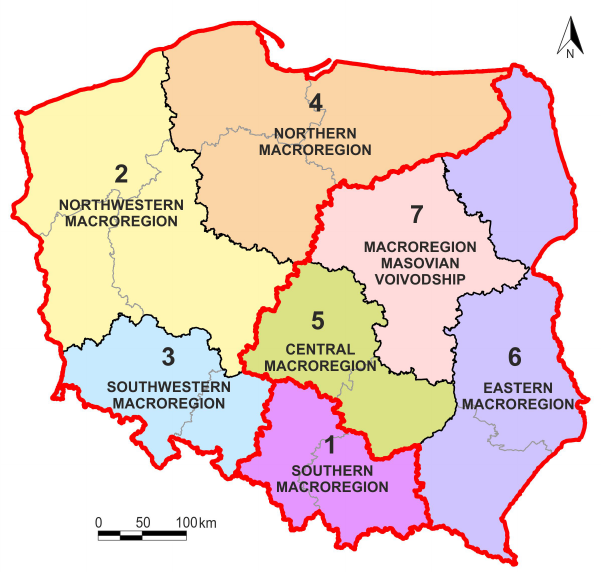
Figure 4. Super macroregions and macroregion of Poland. Source: own